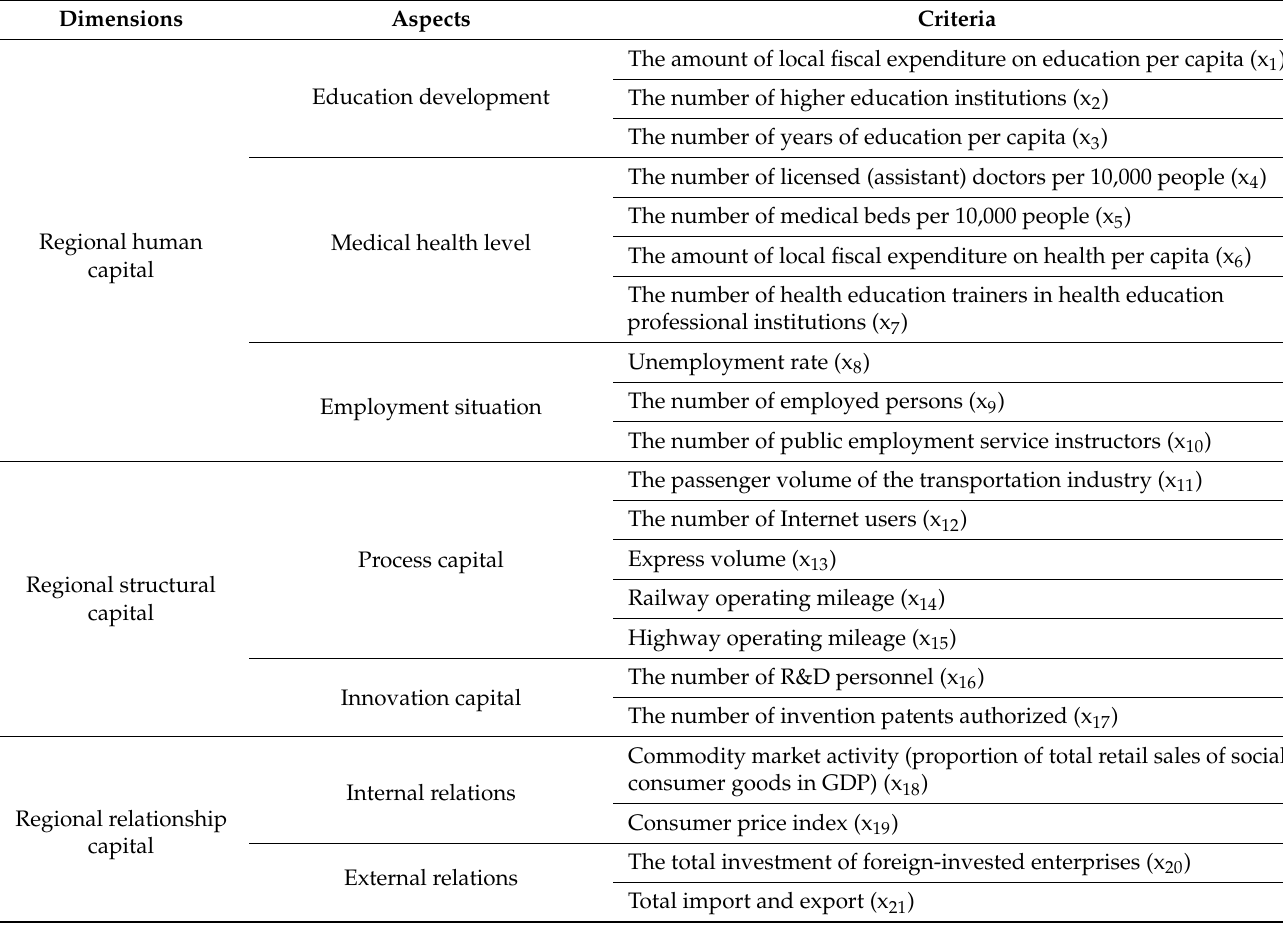
Table 6. The formal decision